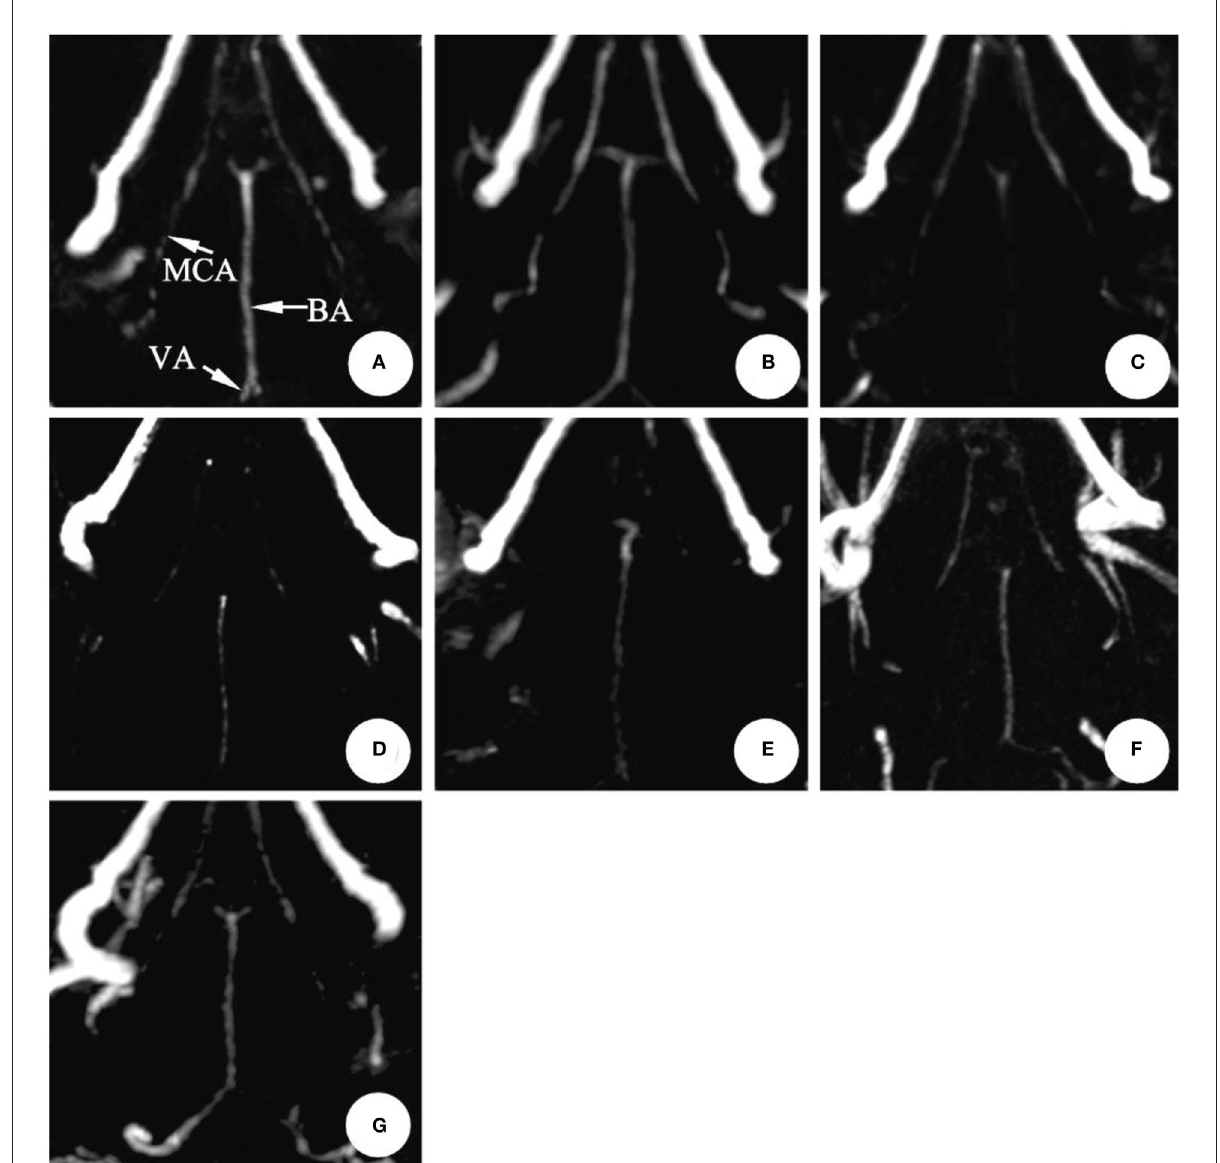
FIGURE3 The magnetic resonance performance of artery in the same rabbit SAH model within 0 ∼ 11 d (3D-TOF-MRA). The diameter showed no significant changes after making the model in 1 d. It reached the peak in 3 ∼ 5 d and gradually recovered during 7 ∼ 11 d.BA, Basilar artery; MCA, Middle cerebral artery; VA, Vertebral artery. (A) 0 d; (B) 1 d; (C) 3 d; (D) 5 d; (E) 7 d; (F) 9 d; (G) 11 d.